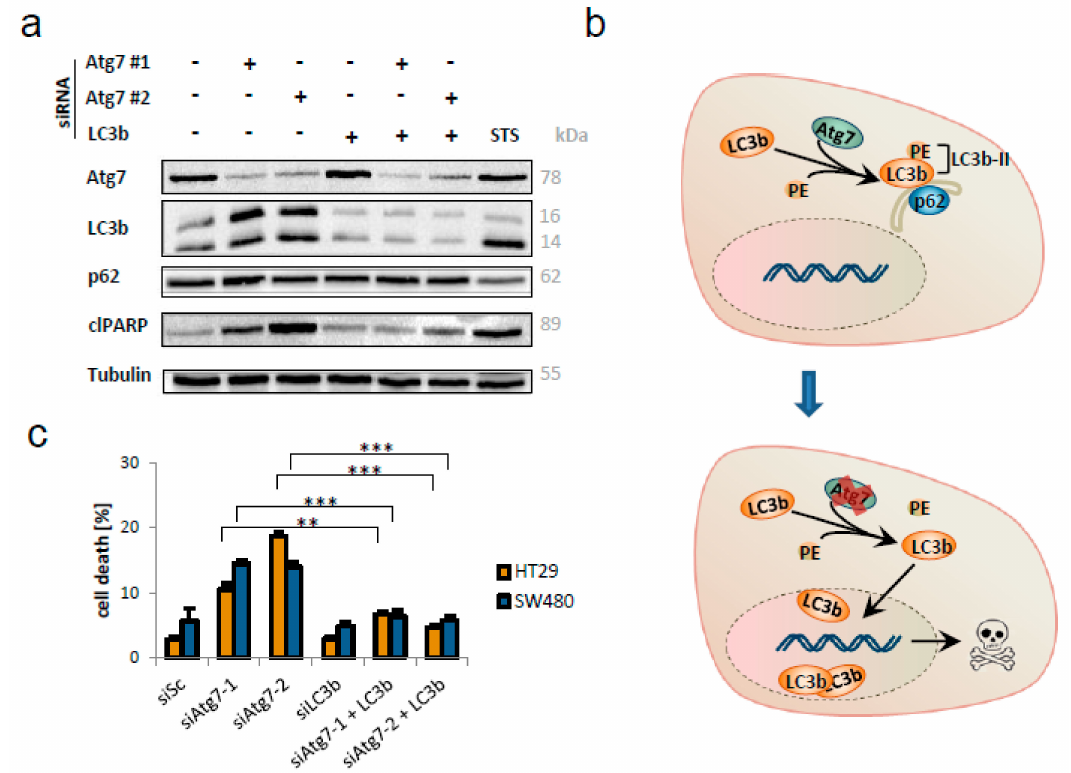
Figure 5. Additional knockdown of LC3b protected colorectal cancer cells from siAtg7-induced apoptosis. ( a ) Immunoblotting of HT29 cells 48 h post-transfection with siRNAs targeting Atg7 (#1 and #2) and / or LC3b (80 nM each). Staurosporine (STS, 2 µ M, 4 h) served as positive control for apoptosis induction indicated by cleaved PARP. ( b ) Graphical synopsis of the assumed mechanism of LC3b mediated cell death in CRC cells after knockdown of Atg7. PE = Phosphatidylethanolamine. ( c ) Quantification of cell death in SW480 and HT29 cells, measured by flow cytometry 48 h after transfection with siRNAs targeting Atg7 (#1 and #2) and / or LC3b (80 nM each). Data represent mean + SD of independent biological triplicates. ** = p < 0.01, *** = p <